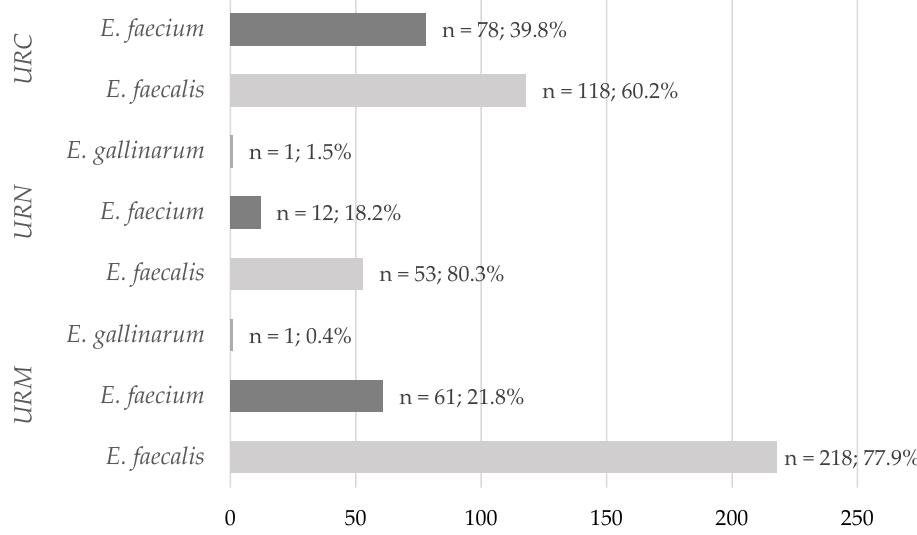
Figure 1. Percentage of E. faecalis and E. faecium strains isolated from different types of urine samples in Nephrology and Urology clinics over the years 2016–2021 (n = 542). URC—urine samples collected through the catheter, URM—midstream urine samples, URN—urine samples collected from a nephrostomy.